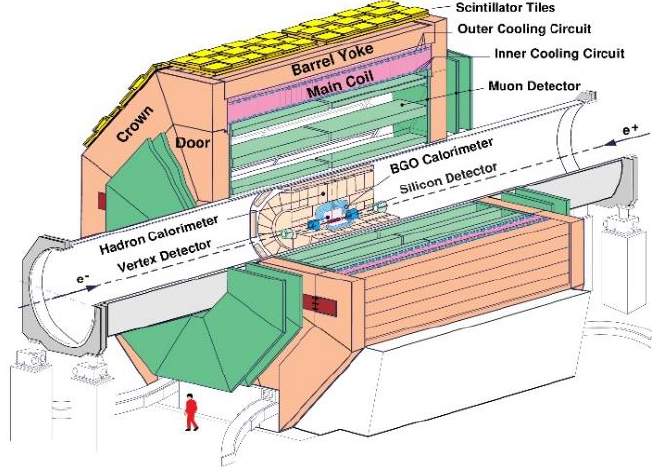
Figure 2. The L3 spectrometer. Only the muon detectors, the magnet, and the scintillator tiles were used in this experiment.